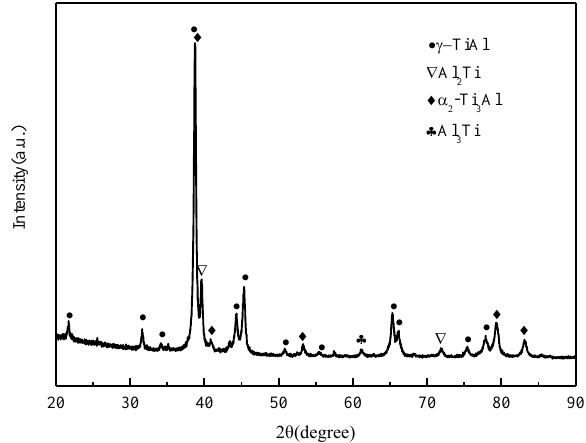
Figure 9. XRD pattern of TiAl alloy after the sintering process.